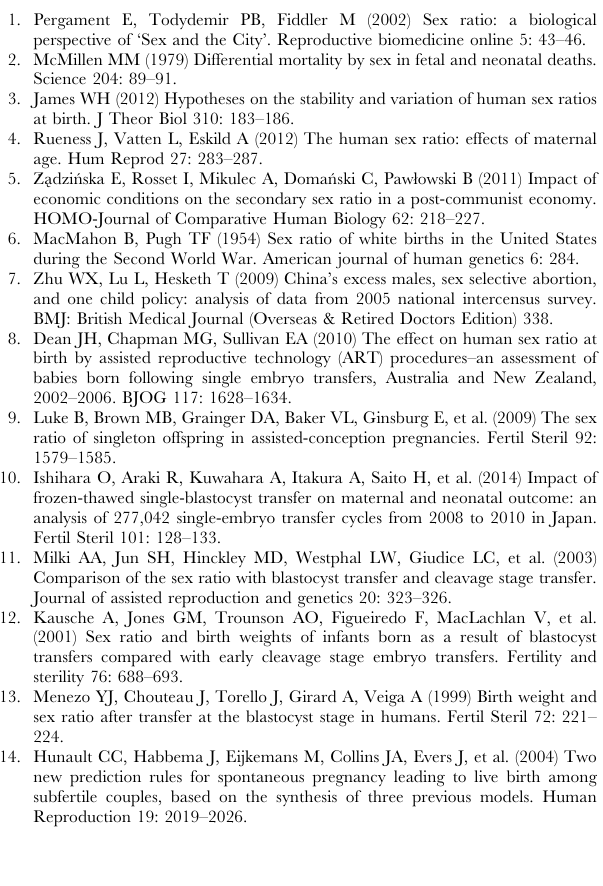
Table S1 Basic characteristics of 5,790 mothers with singleton birth in one